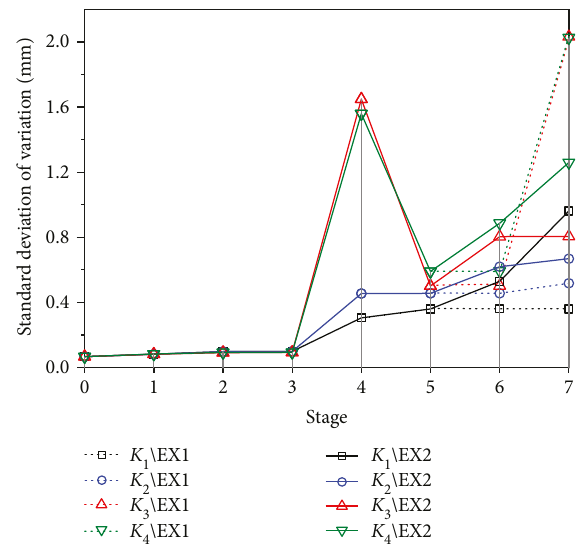
Figure 10: Standard deviations of variations throughout the assembly